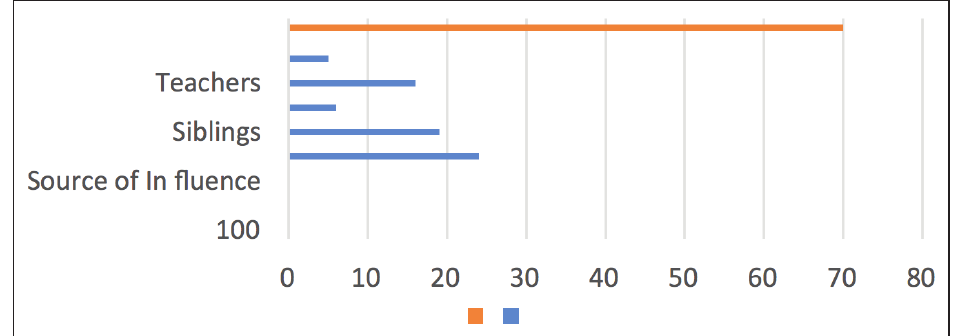
Figure 2. Number of Influenced Participants and Source of